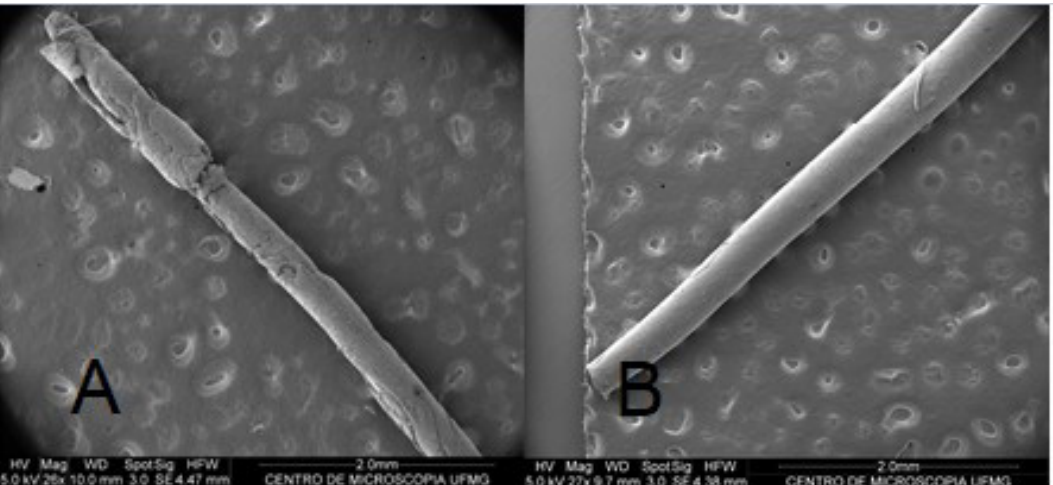
FIGURE 5 - Micrographs of CBV-PLGA (A) and NBV-PLGA (B) implants at 26x magnification. The homogeneous surface without fractures of the implants is